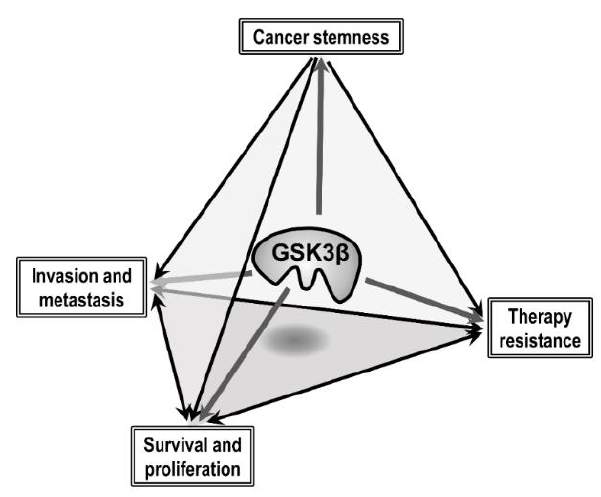
Figure 2. Schematic representation of the hypothesis that GSK3 β is central to the interconnection between several of the biological hallmarks of cancer, including tumor cell survival and proliferation, invasion and metastasis, cancer stemness and resistance to therapy.